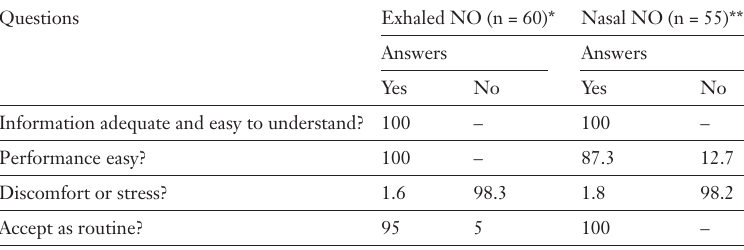
Acceptability of exhaled and nasal NO measurements in routine clinical practice.